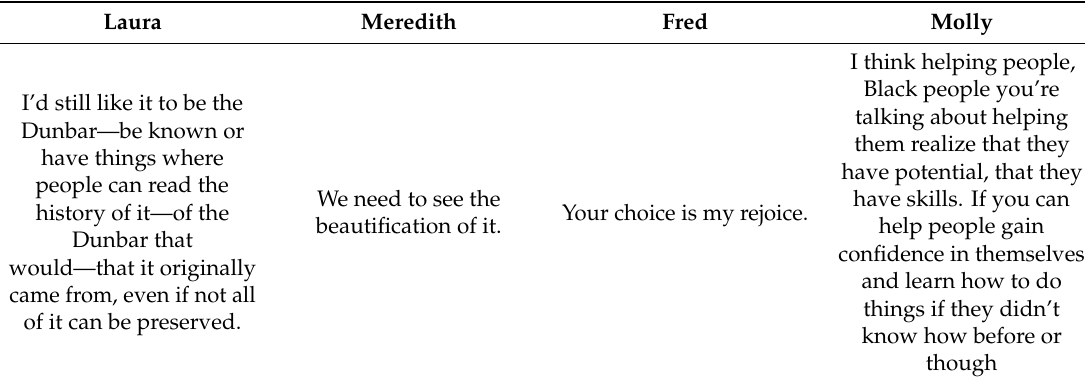
Table 5. Emergent Themes for